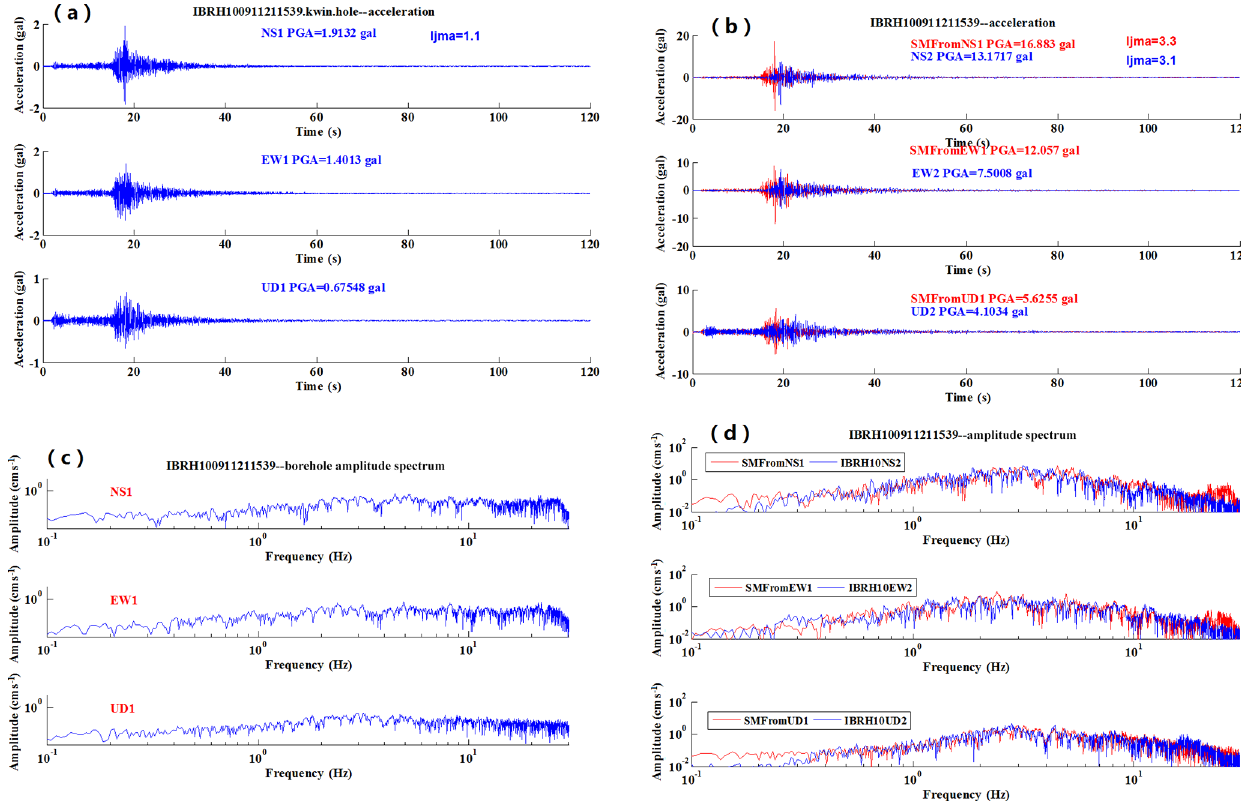
Figure 6. An example of the results of simulation for IBRH100911211539: (a) the observed acceleration at the borehole, (b) the observed surface acceleration waveform (blue) compared with the simulated one (red), (c) the spectra of the observed borehole record, and (d) the spectra of the observed surface record (blue) compared with the simulated one (red). Table 3. Information for M 5 . 2 earthquake (IBRH10 and IBRH19 for 201202191454). PGA (gal) PGA amp. I jma IBRH19 IBRH10 Amp. (IBRH100 / IBRH19) IBRH19 IBRH10 Res. (obs. −